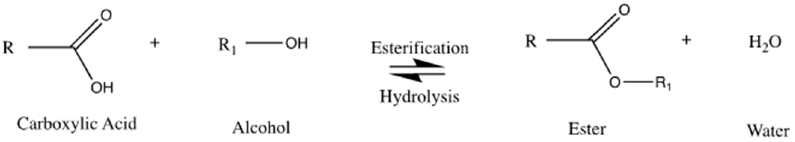
Figure 3. Lipase-catalyzed activity; equilibrium between esterification and hydrolysis.